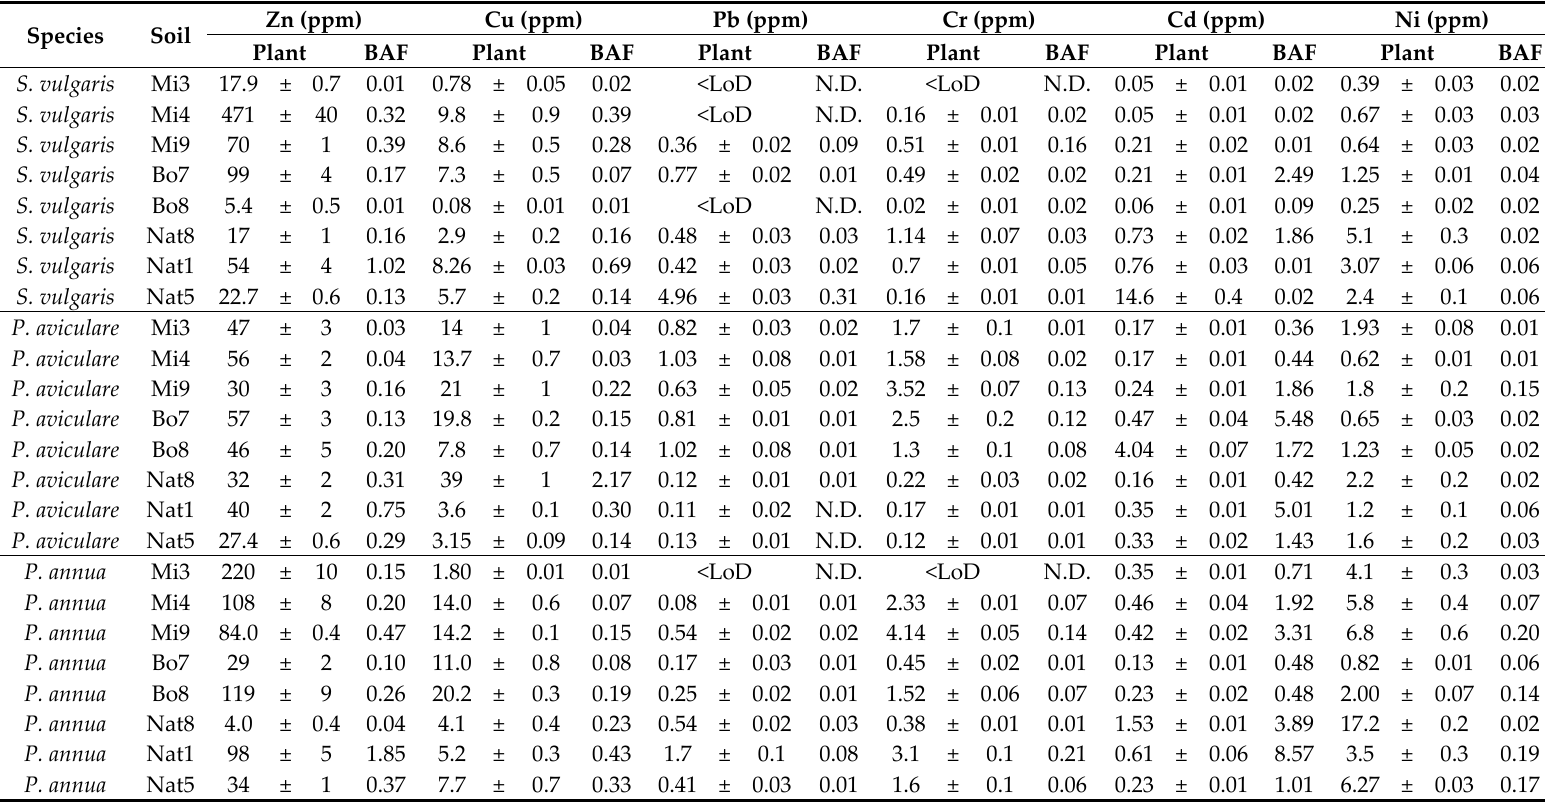
Table 5. Metal concentrations and bioaccumulation factor (BAF) for the three studied species.